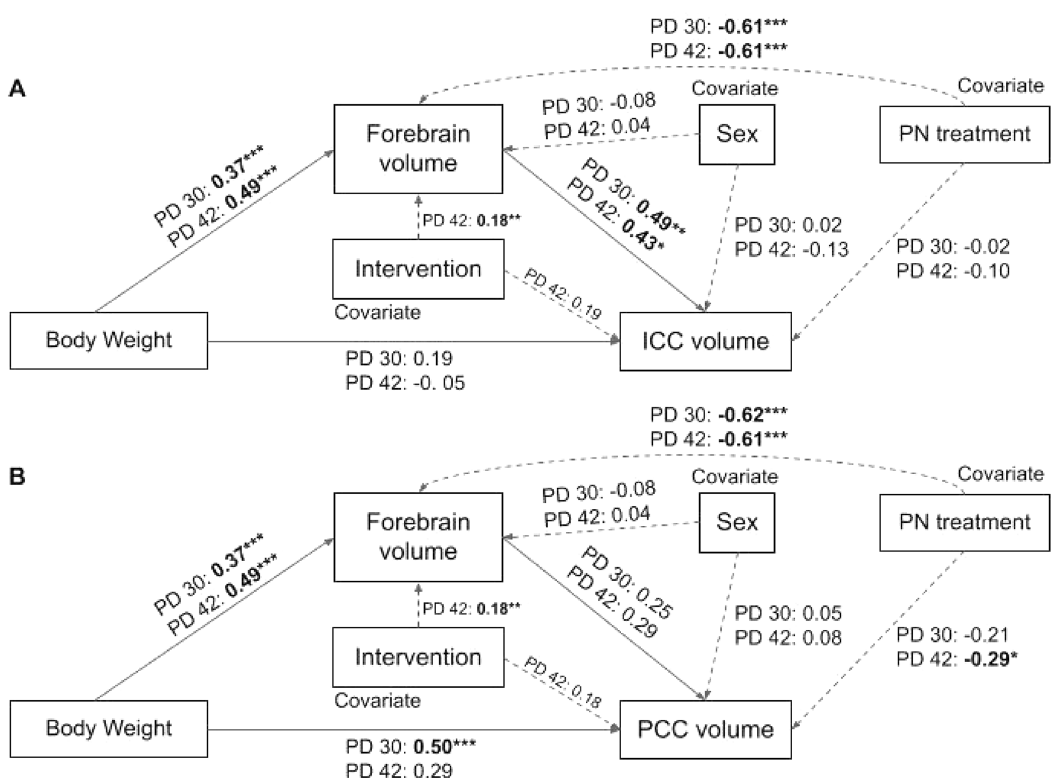
Figure 6. Statistical models for the regression-based mediation analyses which illustrate that body weight indirectly affects ICC ( A ) but not PCC ( B ) volumes through alterations to forebrain volume on PD30 and 42. Conversely, body weight influences PCC volume directly on PD30 only. All values represent standardized regression coefficients. Bolded coefficients indicate statistically significant relationships. Factors: body weight, ICC/PCC volume; Mediator: Forebrain volume; Covariates: sex, postnatal treatment group, and intervention group. N = 80, *** p < .0001, ** p < .01, * p <